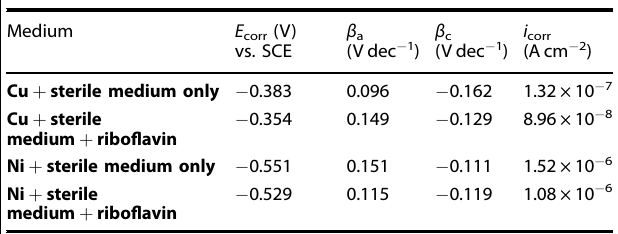
Table 4. Tafel parameter for Fig. 9f. Medium